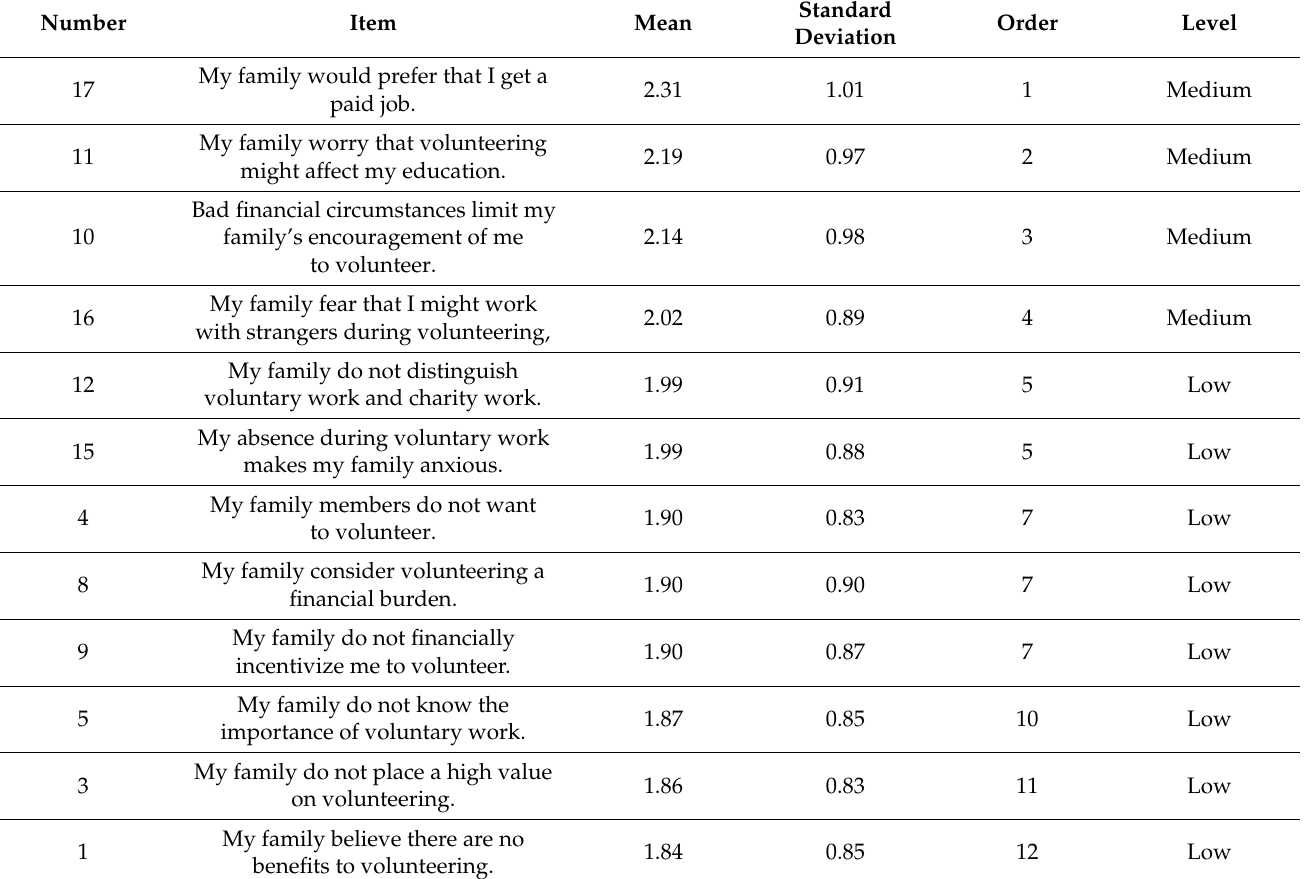
Table 4. Means and standard deviations of the responses of the study’s participants to the items included in “the familial obstacles to youths’ participation in voluntary work” listed in descending order by